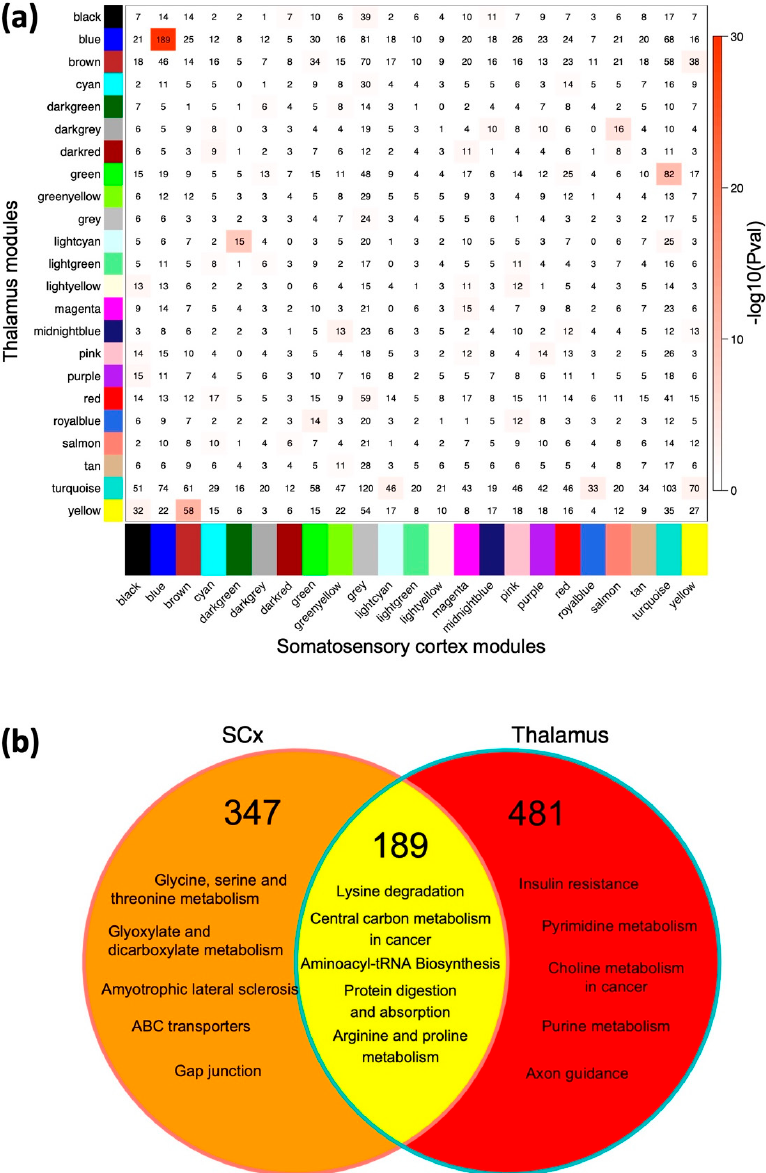
Figure 5. The overlap between cortical and thalamic modules. ( a ) A contingency table of overlapping proteins/metabolites between all pairs of cortical ( x -axis) and thalamic ( y -axis) modules. Each block in the table shows the number of overlapping proteins + metabolites in the intersection of corresponding cortical and thalamic modules. The table is color-coded with − log10 of the p value associated with the Fisher exact test. ( b ) A Venn diagram depicting the enriched pathways as determined by the joint pathway enrichment analysis of the region-specific and common/overlapping proteins + metabolites from the seizure-associated Blue modules. The diagram is color-coded with the number of region- specific and common proteins + metabolites in the two Blue